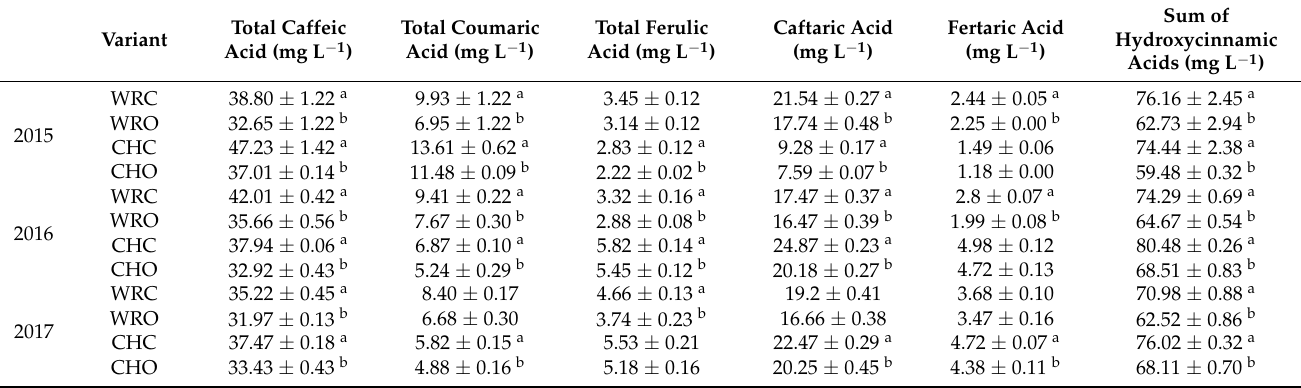
Table 2. Hydroxycinnamic acids content in the experimental variants in vintages 2015–2017.